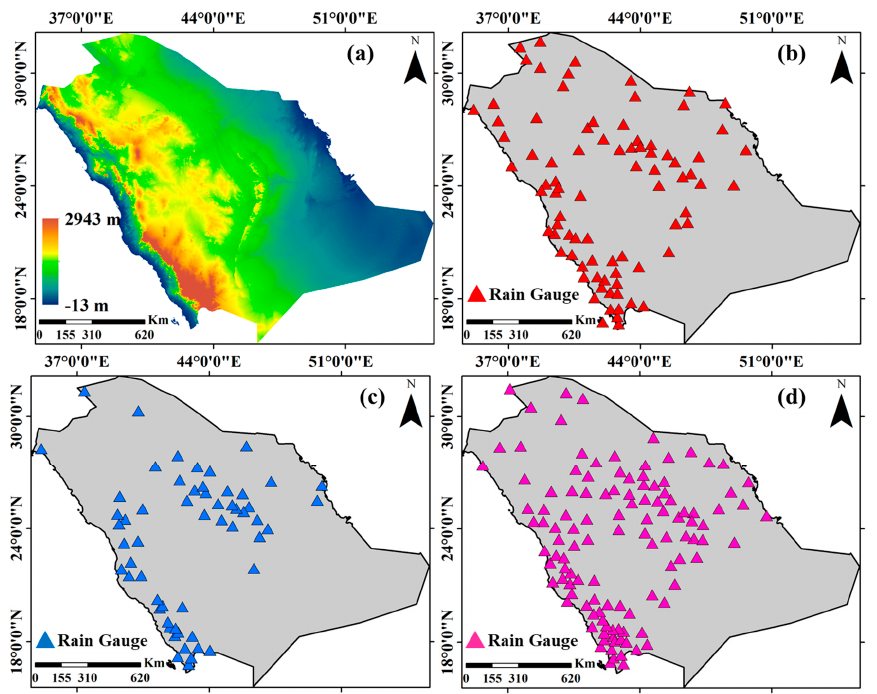
Figure 1. Maps of: ( a ) digital elevation model of the study area and spatial distribution of ( b ) gauge stations used in interpolation-based precipitation map generation; ( c ) gauge stations used in calibration of the proposed method; and ( d ) gauge stations used in accuracy evaluation of existing products and proposed method in precipitation estimation.